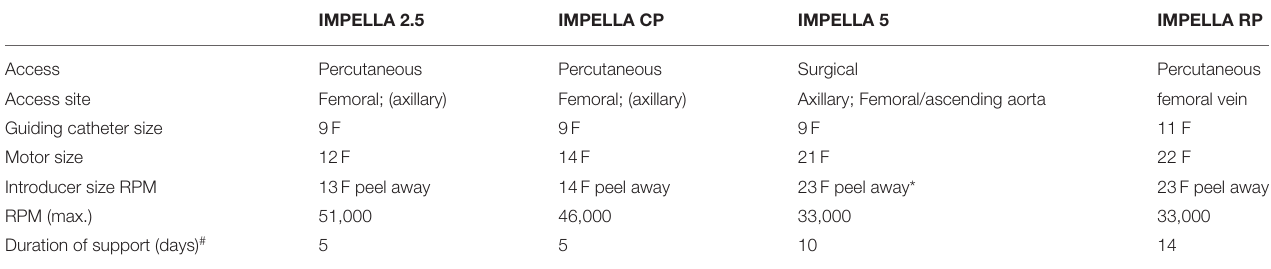
TABLE 2 | Impella devices and pump